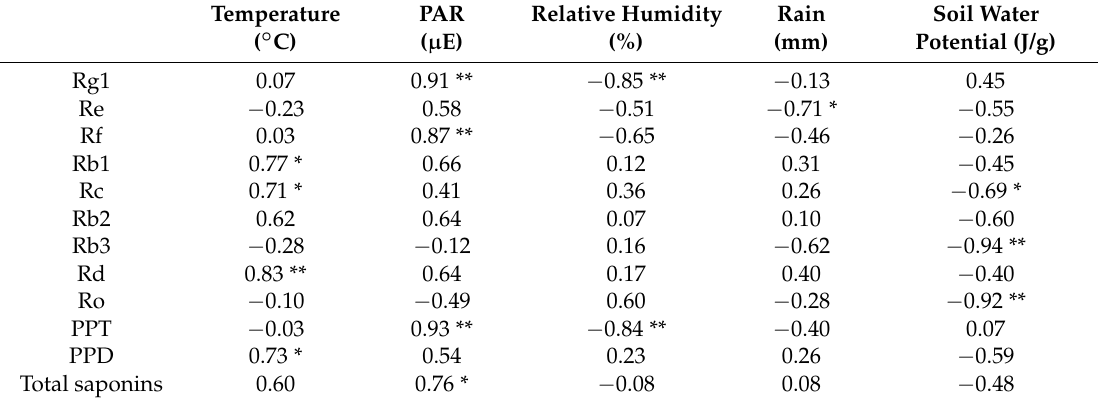
Table 7. Correlation analysis between environmental factors and ginsenosides in roots at different growth times.